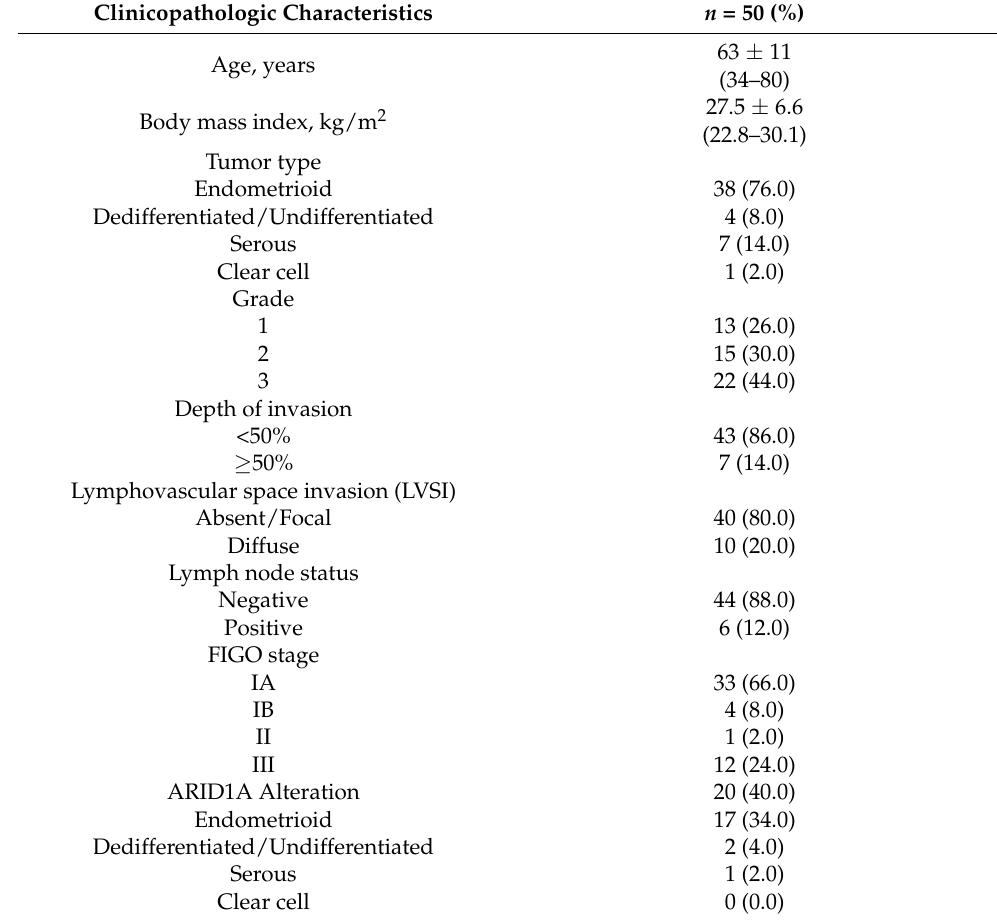
Table 1. Clinicopathologic characteristics of the study sample. Values are counts (percentages) or mean ± standard deviation (interquartile